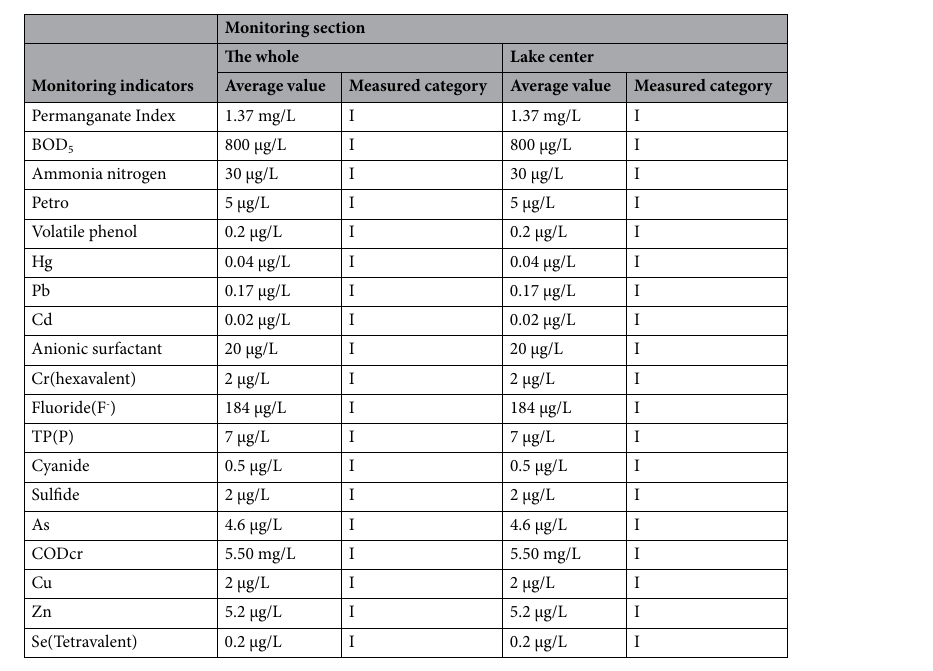
Table 5. Statistical results of various indicators in Lugu Lake in